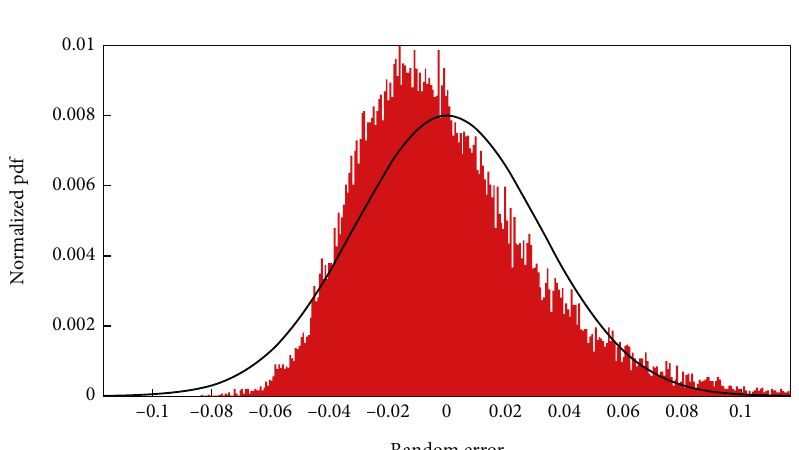
Figure 4: Gyroscope noise.